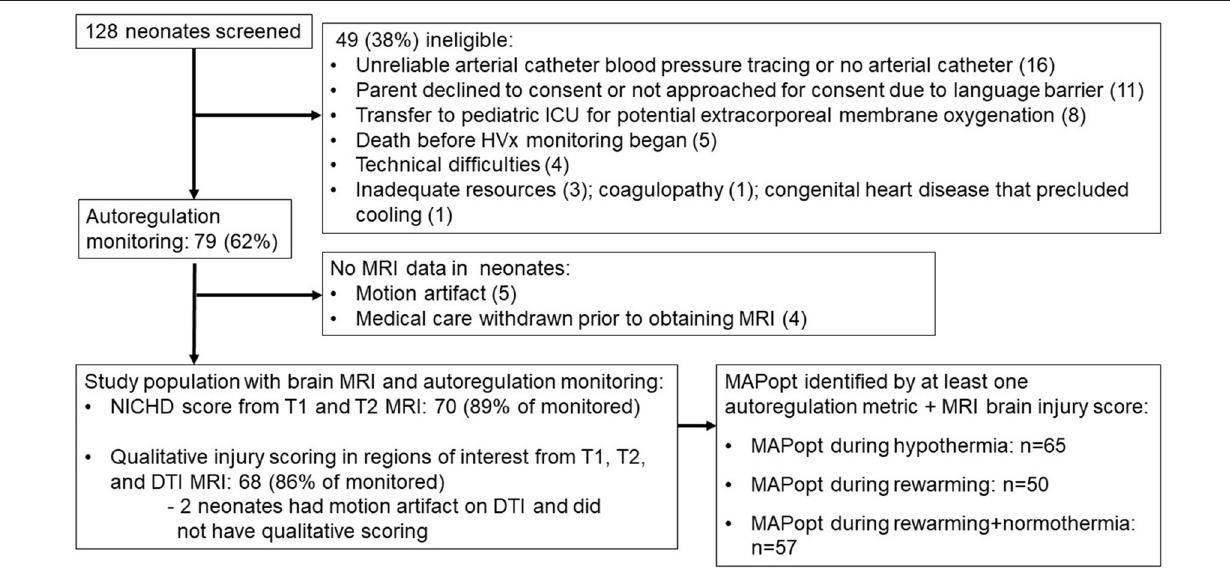
Frontiers in Neurology |